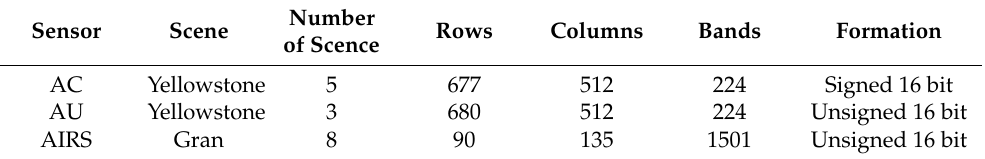
Table 1. The sensor names and their main